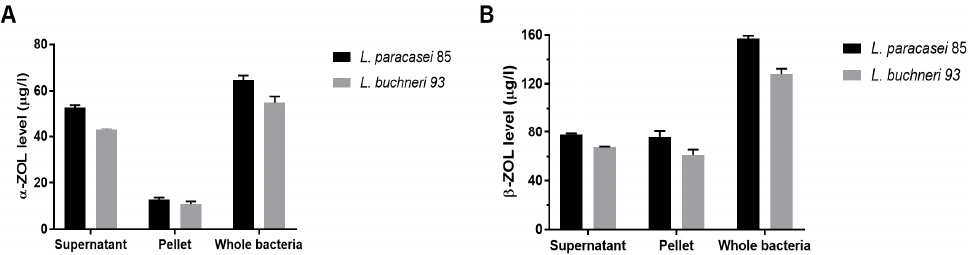
Figure 3. The levels of α‐ ZOL and β‐ ZOL in the supernatant, pellet, and whole bacteria of L. paracasei 85 and L. buchneri 93 after ZEN co ‐ incubation. ( A ) The levels of α‐ ZOL, ( B ) The levels of β‐ ZOL.